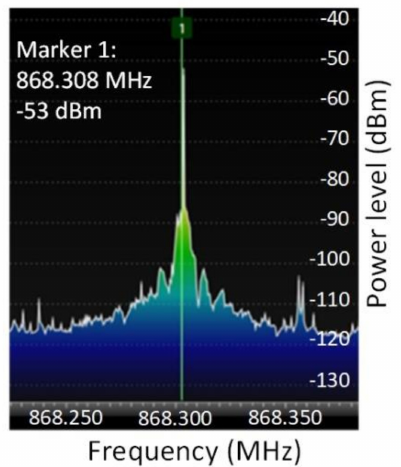
Figure 12. LoRa packet spectrum. The packet created by the LoRa tra ffi c generator respects the LoRaWAN specifications and is received correctly by the gateway module.